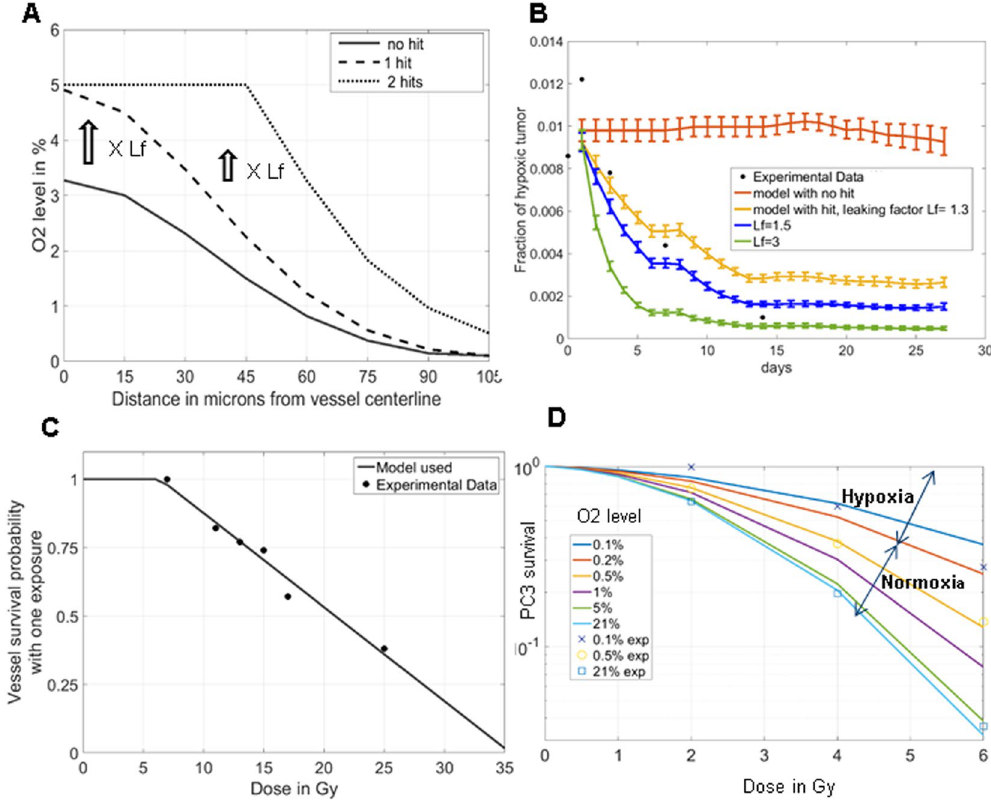
Figure 3. Modeling the impact of oxygen on radiotherapy. ( A ) Previously published model of O2 “leakage” 5 derived from a Monte Carlo approach with a probability of “hitting” a vessel after a given dose defined by the corresponding cell death probability of endothelial cells measured in vitro . If there is a “hit” to a blood cell, a multiplicative factor Lf is applied to the profile. ( B ) Determination of Lf based on the experimental evolution of the fraction of hypoxic tumour over time: leakiness of 50% (leaking factor of 1.5) led to most accurate prediction of the published 5 fraction of hypoxic surface drop (blue curve versus circles). ( C ) Model of the vessel survival probability against a single dose, fitted from previously published experimental data 23 . ( D ) HRF « hypoxia reduction factor » was fitted using a Howard-Flanders fit based on our previous published data 5 (See Fig. S4). Survival curves of tumour cells can then be predicted for various O2 levels using the fitted HRF. Tumour cell death at full oxygenation is based on the PC3 LQ data: alpha = 0.0441, beta = 0.0898. The predictive curves accurately overlap previous experimental